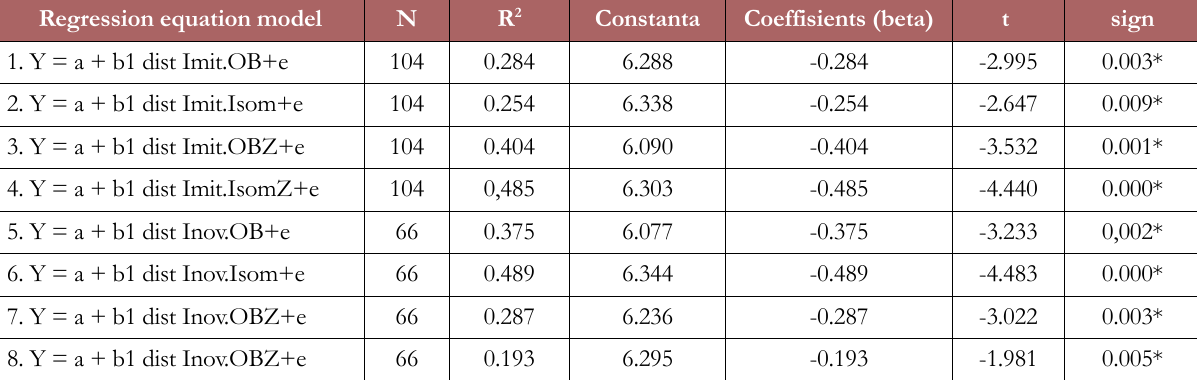
Table 3. The Summary of Regression Test